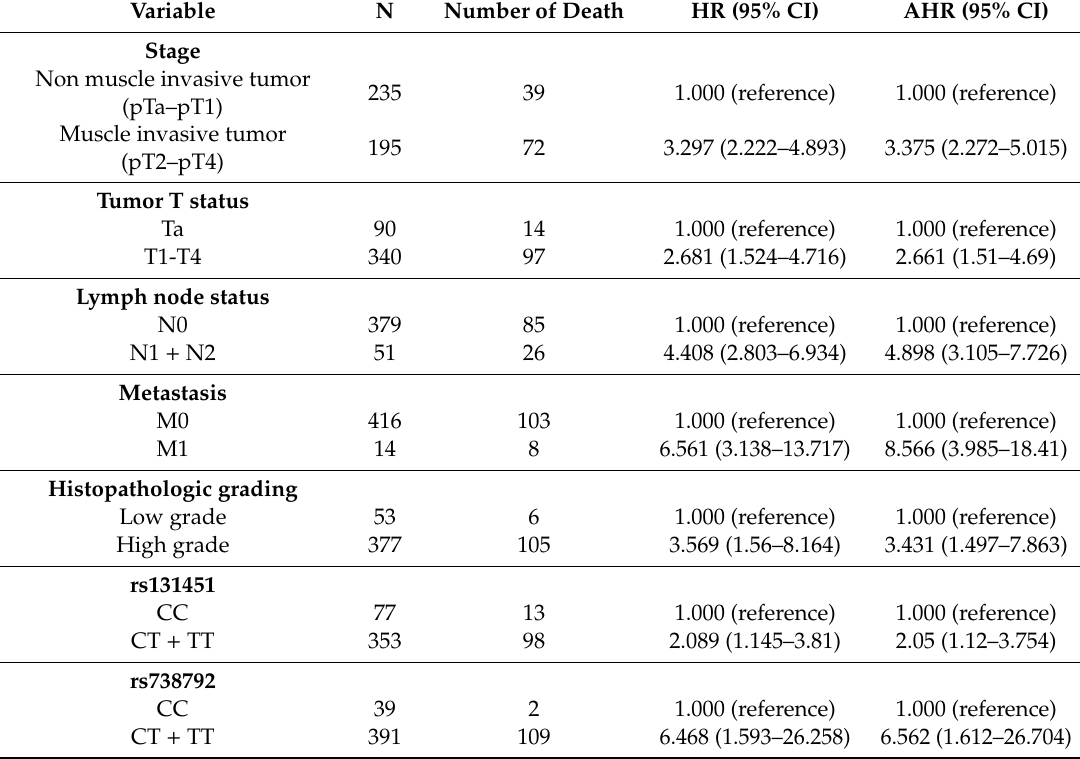
Table 5. Risk of death on genotypic distributions of MMP11 gene polymorphisms (rs131451, rs738792) among 430 UCC